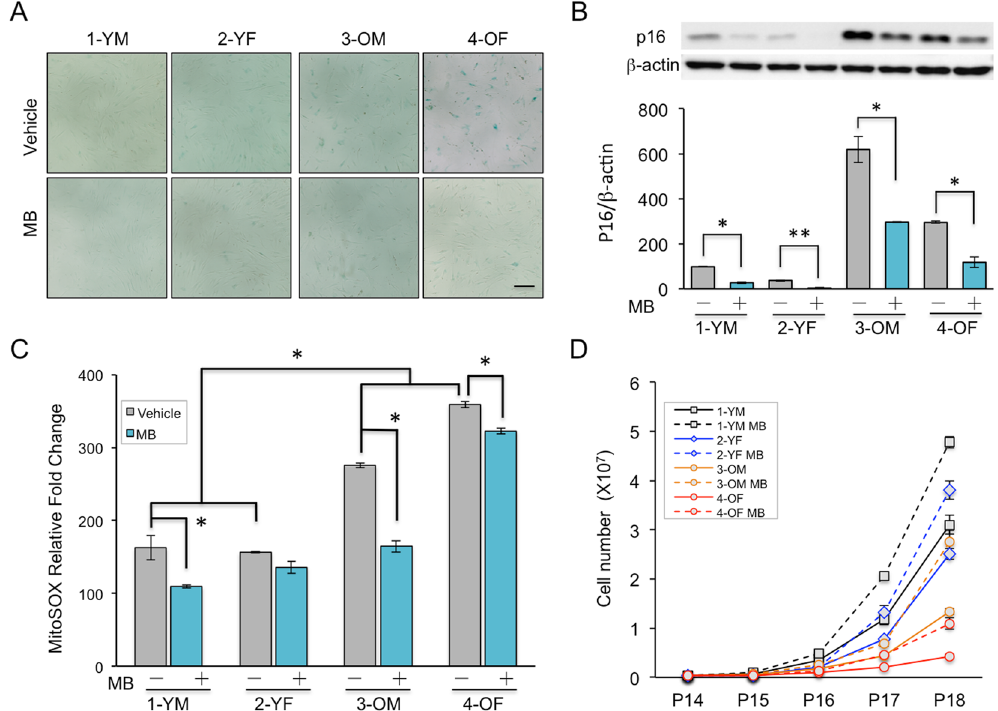
Figure 2. MB reduces aging signs in old skin cells. ( A ) The images of senescence-associated β -galactosidase (SA- β -gal) staining in two young (1-YM & 2-YF) and two old (3-OM & 4-OF) human skin fibroblast lines that were treated with vehicle or 100 nM MB for four weeks. Scale bar = 200 μ m. ( B ) Western blotting analysis with an anti-p16 antibody in the two young (1-YM & 2-YF) and two old (3-OM & 4-OF) cells after four weeks of treatment with vehicle or MB at 100 nM. ( C ) Relative fold change of mitochondrial superoxide (MitoSOX) levels in the two young and two old fibroblasts after four weeks of treatment with vehicle or MB 100 nM. ( D ) Growth curves for vehicle- (solid lines) or MB- (dashed lines) treated young and old fibroblasts during the four-week treatment of each drug. ( * p < 0.05, ** p <